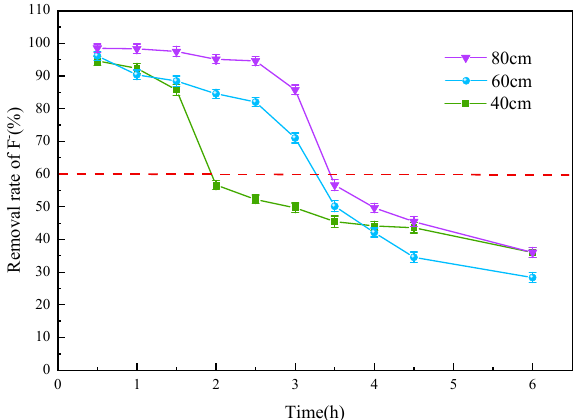
Figure 13. Effect of adsorbent thickness in an adsorbent column. The initial F − concentration was set to 1 × 10 − 2 g/L, PH was set to 7, and flow speed was set to 4 mL/min.